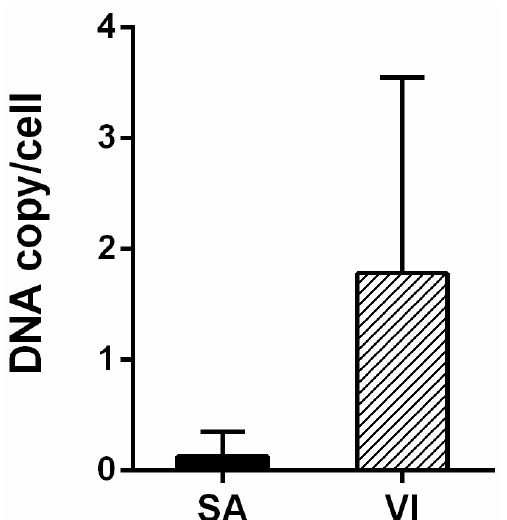
Figure 1. Mean HPV DNA load detected by ddPCR. Mean HPV DNA load (viral DNA copy / cell) was determined in HPV-positive chorionic villi specimens from SA ( n = 3) and VI ( n = 4) women. Error bars represent standard error of the mean (SEM). The difference in viral load between the SA and VI groups was not statistically significant ( p > 0.05).